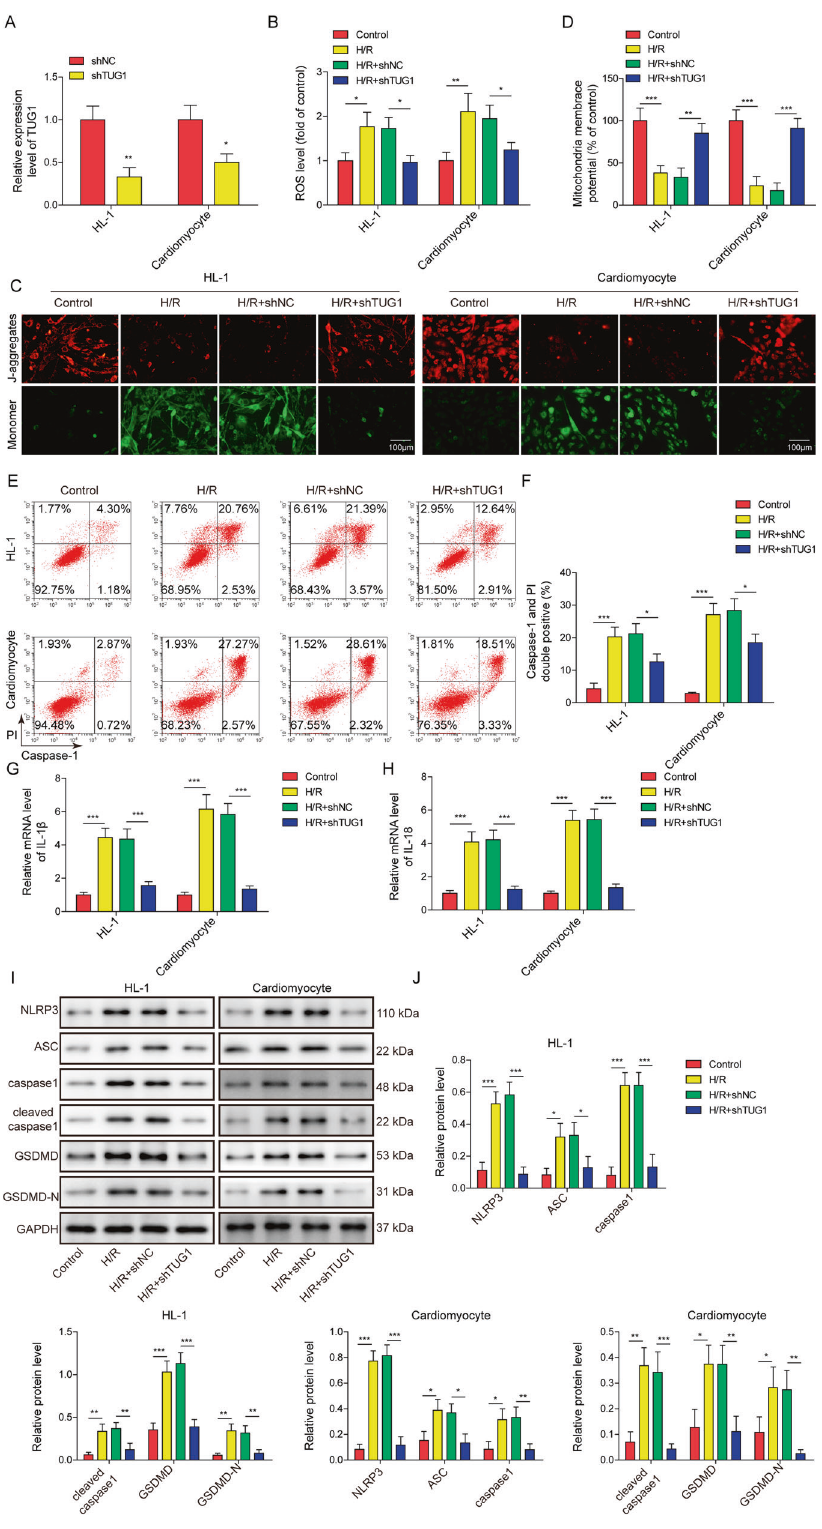
Fig. 3 Silencing TUG1 inhibited H/R treatment-induced mitochondrial dysfunction and pyroptosis in cardiomyocytes. A qRT-PCR measurement of TUG1 levels in cardiomyocytes transfected with shTUG1 or cshNC. HL-1 and primary mouse cardiomyocytes were transfected with shNC or shTUG1 and then treated with H/R. B ROS levels were measured using a DHE assay. C , D Mitochondrial membrane potential was evaluated using JC-1 staining. E , F Caspase-1 activity was measured using fl ow cytometry. G IL-1 β and H IL-18 expression was measured using qRT-PCR. I , J The expression of pyroptosis-related markers was measured using western blotting. * P < 0.05, ** P < 0.01 and *** P < 0.001.